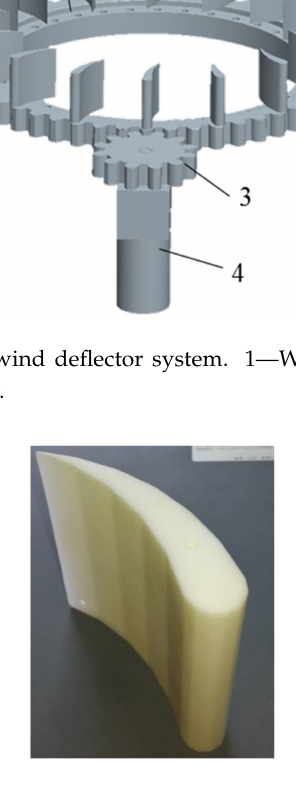
Figure 4. Picture of the wind